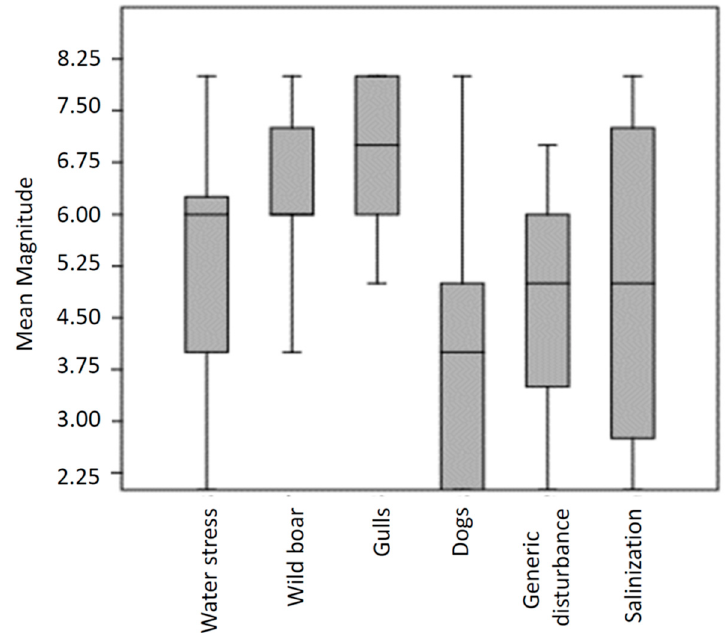
Figure 1. Box plots for magnitude values of the six human-induced direct threats selected by the